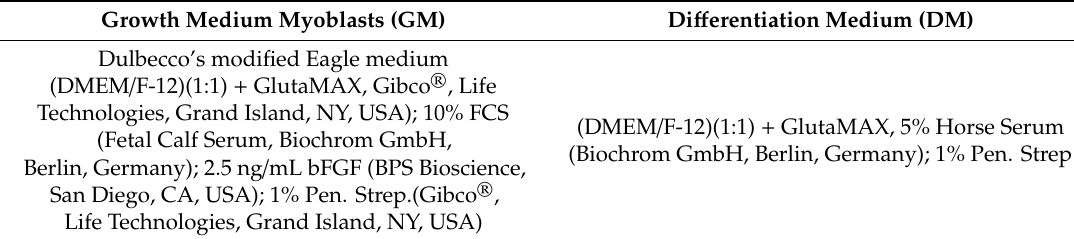
Table 1. Myoblast and myotube